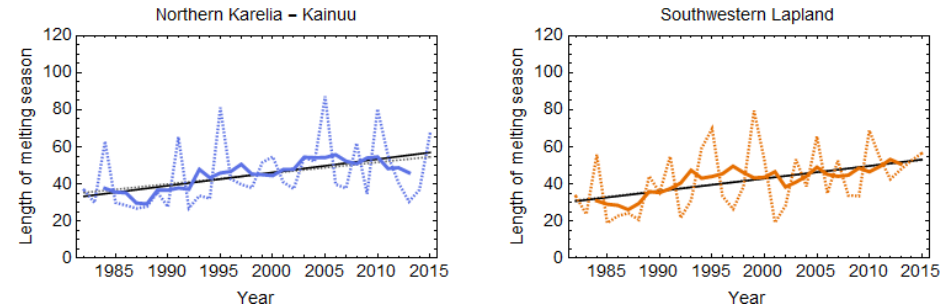
Figure 8. Trends of the melting season length of the snow cover in Northern Karelia–Kainuu and Southwestern Lapland during 1982–2015 based on the CLARA-A2 SAL product. The solid curves represent the 5-year moving averages and the dotted curves the annual